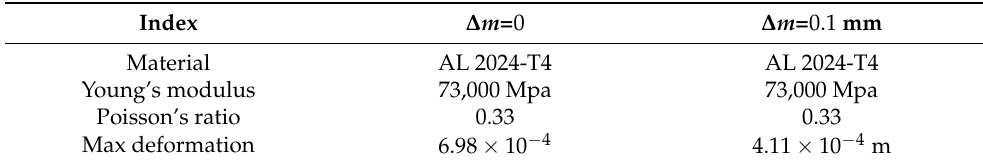
Figure 12. ( a ) The material analysis at Δ𝑚 = 0.1 mm . ( b ) The material analysis at Δ𝑚 = 0 . Table 3. The relevant simulation parameters and results for deployable baffle with ∆ m = 0 and ∆ m =